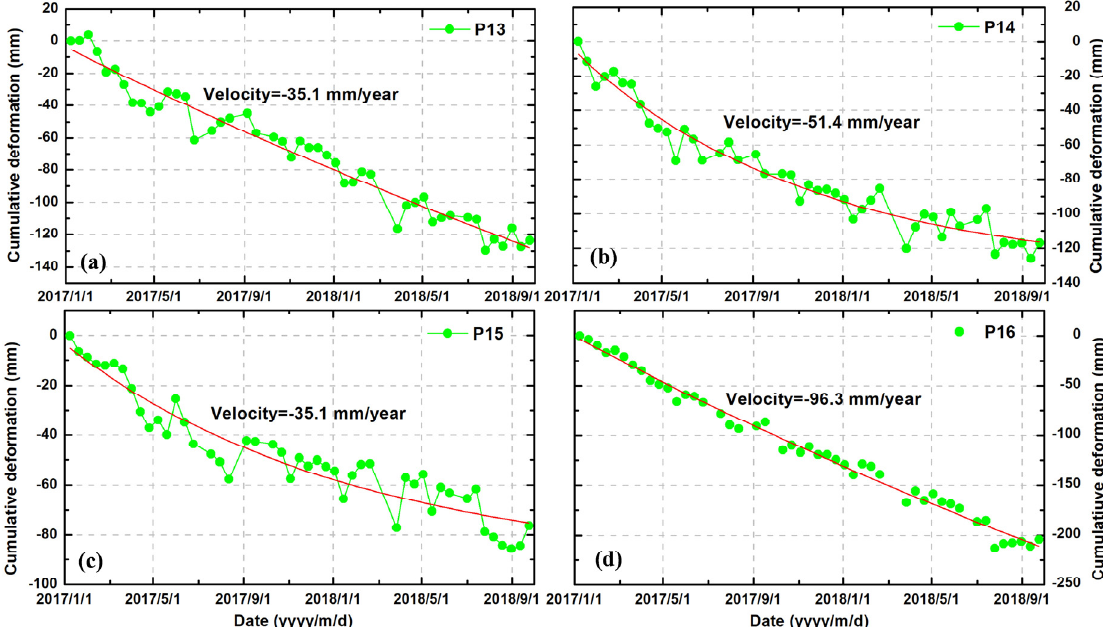
Figure 14. Time series deformation in the vertical direction of Region G from January 2017 and October 2018 for P13 to P16, which are indicated as white dots in Figure 12c. ( a ) Point P13; ( b ) point P14; ( c ) point P15; ( d ) point 16.